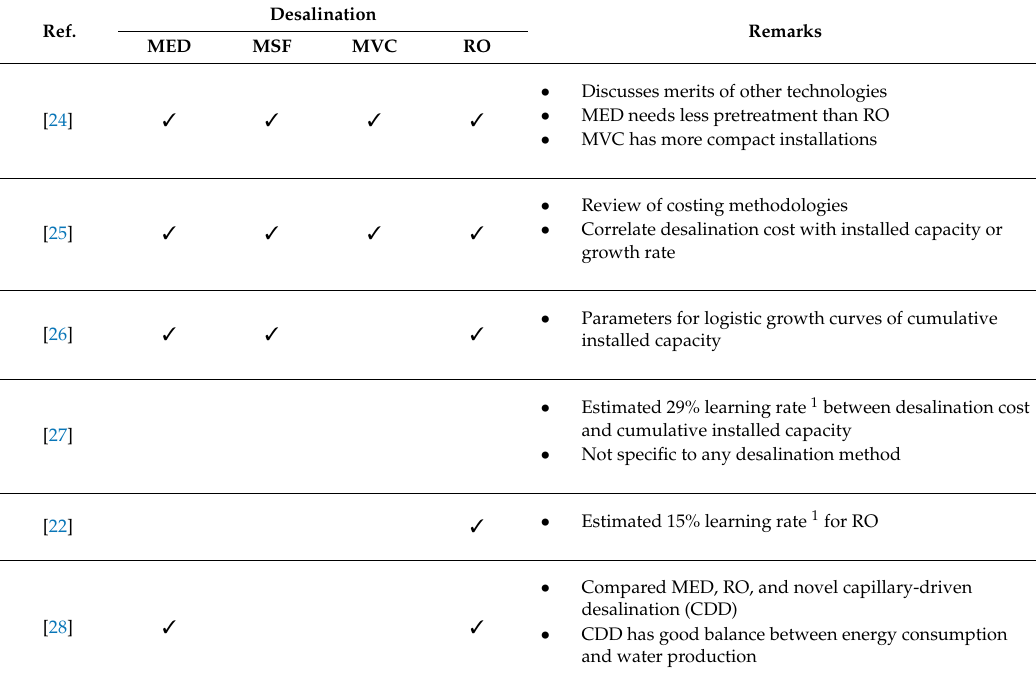
Table 2. Review of comparative desalination studies. MED: multi-e ff ect distillation; MSF: multi-stage flash; MVC: mechanical vapor